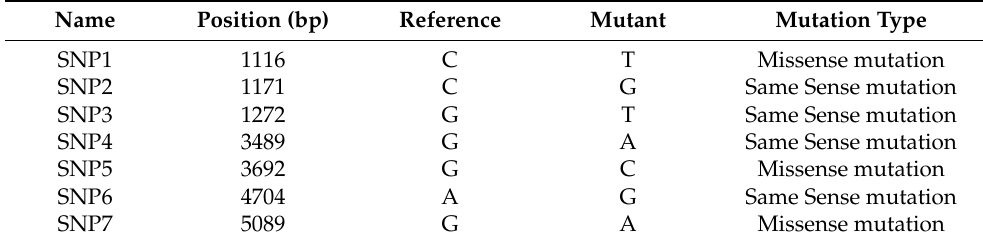
Table 4. Mutation locus of PAPPA2 CDS in Hu sheep.